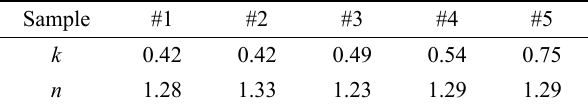
Fig. 5 Coefficient of friction as a function of applied load of five fabric samples Table 2 Experimental and derived data of five